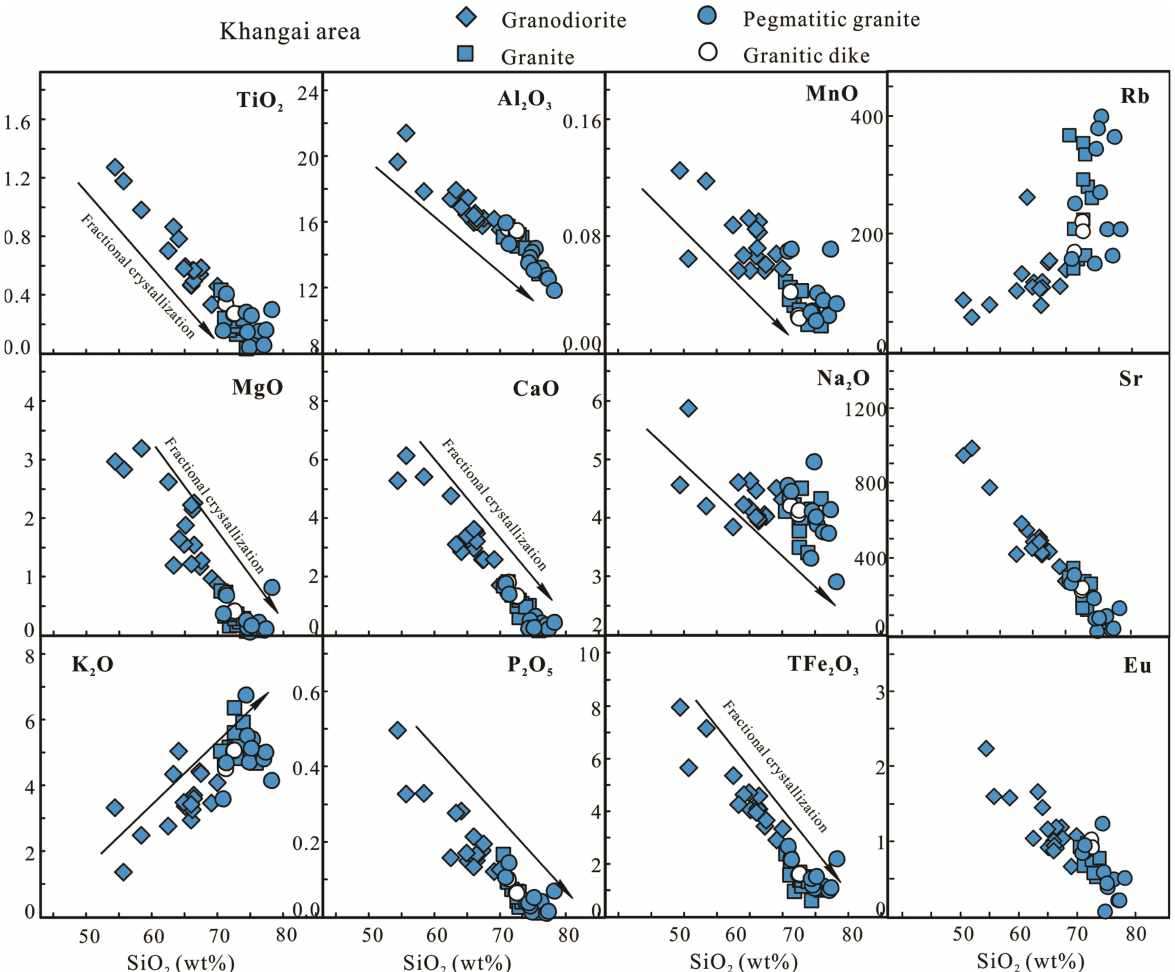
Fig. 7. Harker diagrams showing variations in the composition of granitoids from the Khangai area. Major oxides unit is expressed by weight percent and trace elements unit is expressed by part per million